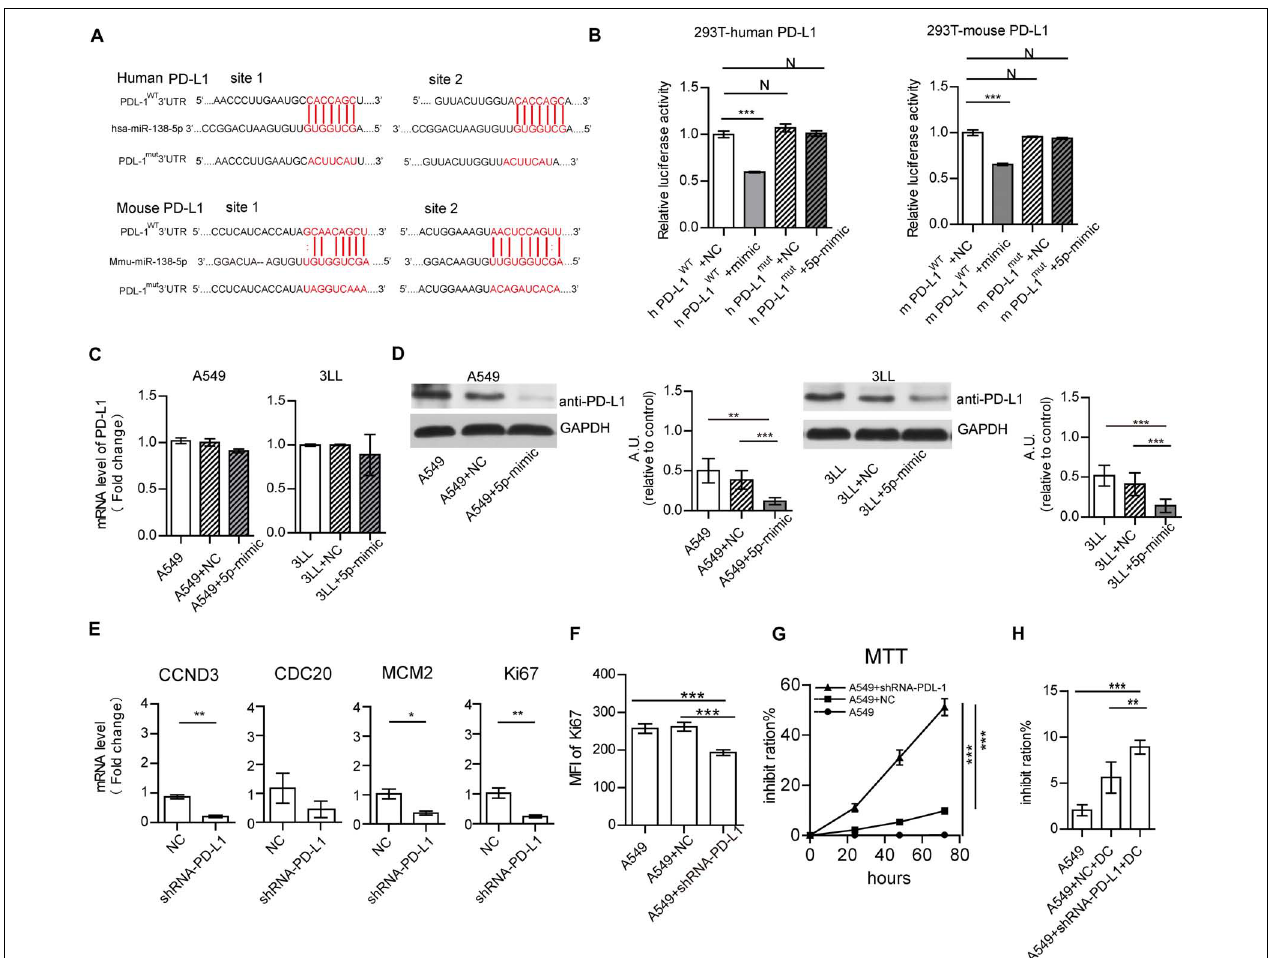
FIGURE 5 | MiR-138-5p targets PD-L1 to decrease proliferation A549 cells. (A) Diagram of the has-miR-138-5p binding site in wild-type (WT) human or mouse PD-L1 3 (cid:48) UTR. The mutation was generated at the binding site (Mut). (B) In a dual-luciferase reporter assay, a luciferase reporter gene containing the WT or Mut human or mouse PD-L1 3 (cid:48) UTR was co-transfected with NC or miR-138-5p mimic into HEK293T cells, and relative luciferase activities were assessed. The gene (C) and protein expression (D) of PD-L1 on A549 cells/3LL cells, which were transfected with NC or miR138 mimic or not. (E) Upon NC, shRNA PD-L1 treatment, the expression levels of CCND3, CDC20, MCM2, and Ki67 were assessed by RT-QPCR. After NC or shRNA PD-L1 silencing in A549 cells, cell proliferation was analyzed by flow cytometry detection of Ki67 (F) or the MTT assay (G) . (H) Percentages of apoptotic A549 tumor cells co-cultured with DCs, which were pretreated or not with shRNA PD-L1 or NC. (* P < 0.05, ** P < 0.01, *** P <